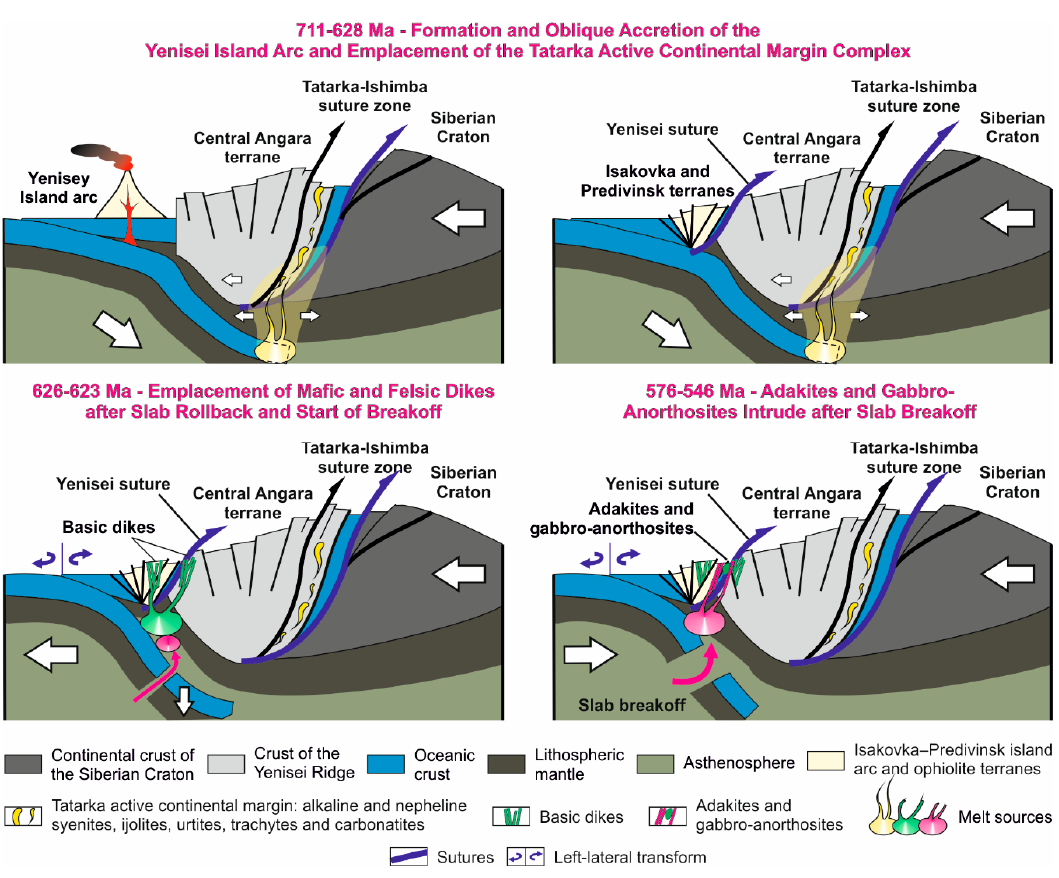
Figure 11. Geodynamic model for the Cryogenian-Ediacaran development stage of the southwestern Siberian active continental margin in the Yenisei Ridge.